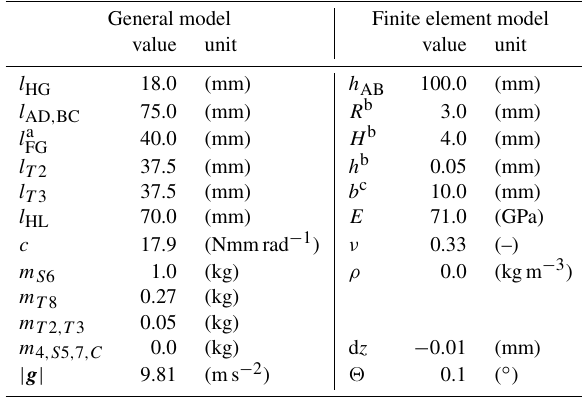
Table 2. Model parameters. General model Finite element model